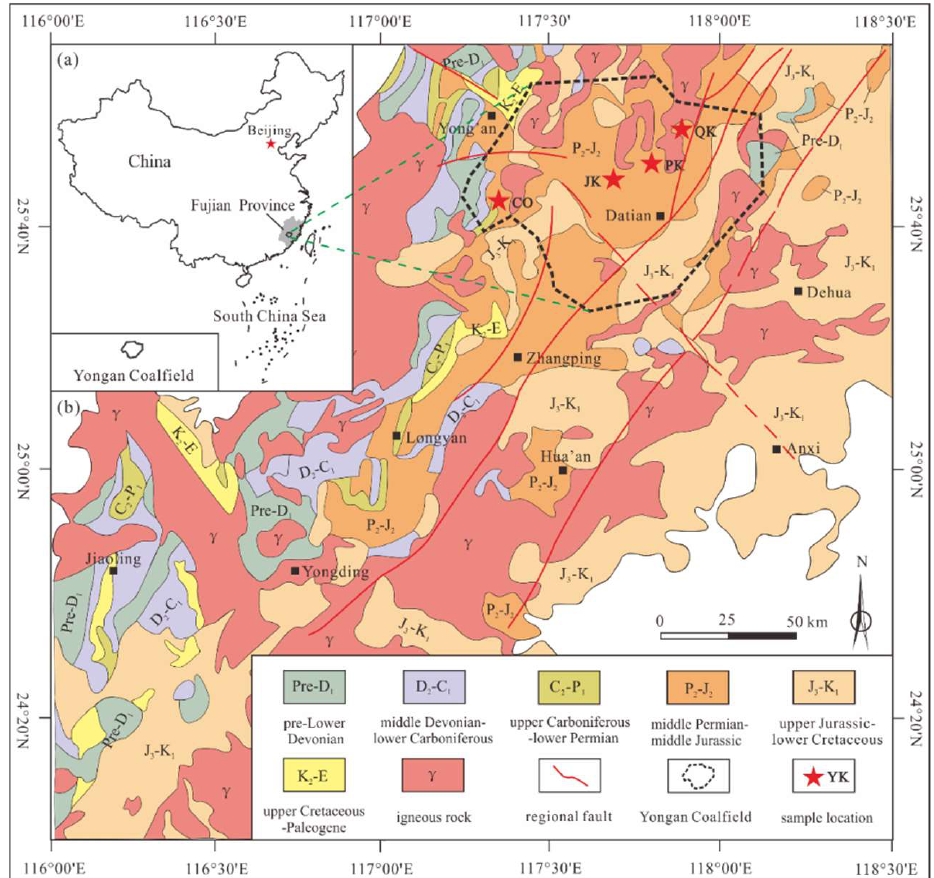
Figure 1. ( a ) The location of Yongan Coalfield; ( b ) Sampling locations and structural outline of the Yongan Coalfield, South China (modified from [7]).